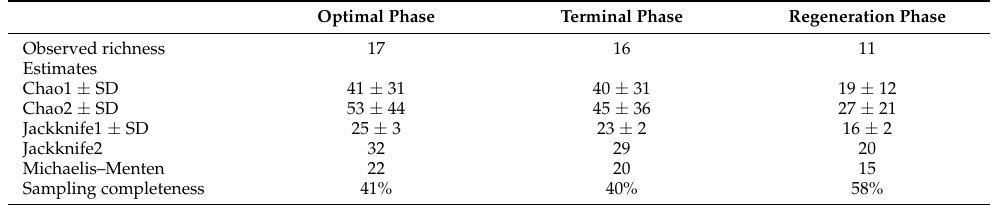
Table 2. Observed species richness and species richness estimates for spider assemblages from tree branches in three developmental phases of oak–lime–hornbeam stand. Sampling completeness was calculated using Chao1